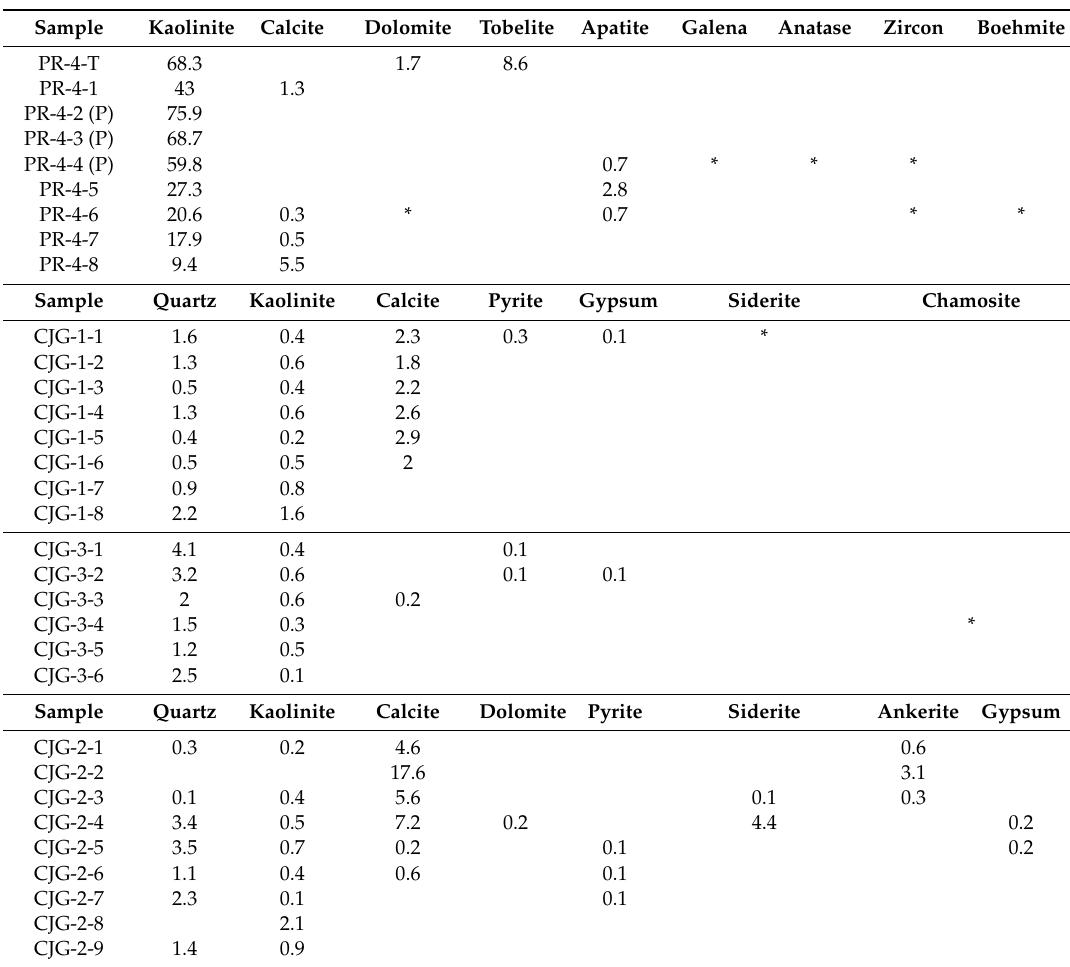
Table 2. Mineral contents in coals and non-coals as determined by X-ray di ff raction (XRD) from the two coal mines (on whole-coal basis; unit in %, db.). The Numbers in this Table represent results of XRD; * represent mineral detected by scanning electron microscopy-energy-dispersive X-ray spectroscopy